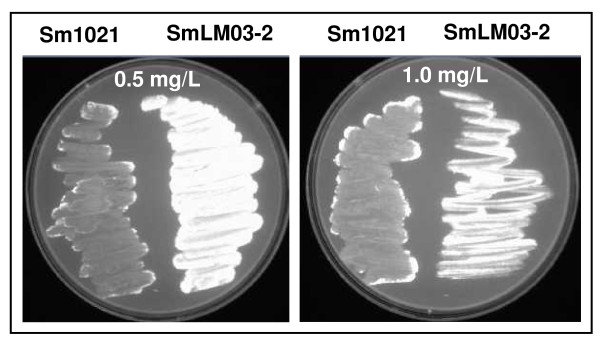
Evaluation of efflux activity. S. meliloti 1021 (left side of the plate) and the tolC mutant SmLM03-2 (right side of the plate) were swabbed in GMS plates containing 0.5 and 1.0 mg/ml of ethidium bromide, following incubation at 30°C for 48 hours and detection under UV light.